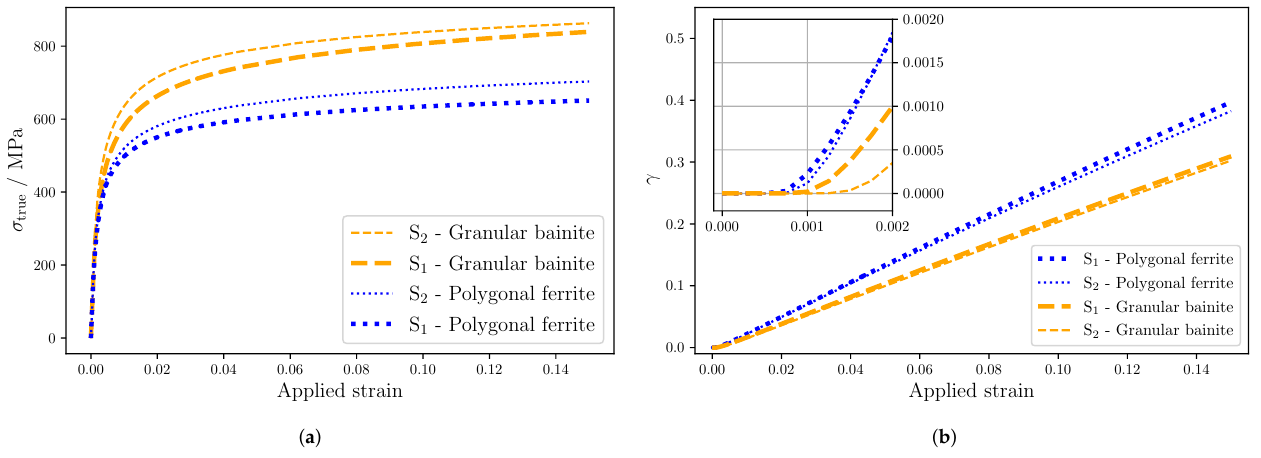
Figure 10. Average stress per phase ( a ) and plastic strain per phase ( b ) in materials S 1 and S 2 . The cumulative plastic shear per slip system is presented in Figure 11. Both materials exhibit a similar behavior. The plastic shear is initially mainly in the 1 2 3 slip planes, { } with some contribution from the 1 1 2 family, while the 1 1 0 is contributing less (S 2 ) { } { } or not at all (S 1 ). The contribution of the 1 2 3 slip system saturates quite quickly and is { } stable throughout the whole deformation process. Note that the contribution of the 1 1 0 { } slip system catches up with the one of 1 1 2 at applied strains of approximately 0.03 and { } 0.01 for materials S 1 and S 2 , respectively. The contributions of both are around 25%, with the 1 1 0 slip system contributing slightly more in the end than 1 1 2 . These results are { } { } similar to those experimentally measured by Tu et al. [14] (51.7%, 15.0%, and 33.3% for 1 2 3 , 1 1 2 , and 1 1 0 , respectively). The contributions at the beginning and at the { } { } { } end of the applied strain are plotted in Figure 12. The main difference can be seen for PF at the initial deformation (see Figure 12a). For material S 2 , the partitioning of γ is between 1 2 3 and 1 1 2 , while for material S 1 , 1 1 0 contributes 0.18% from the start. { } { } { }